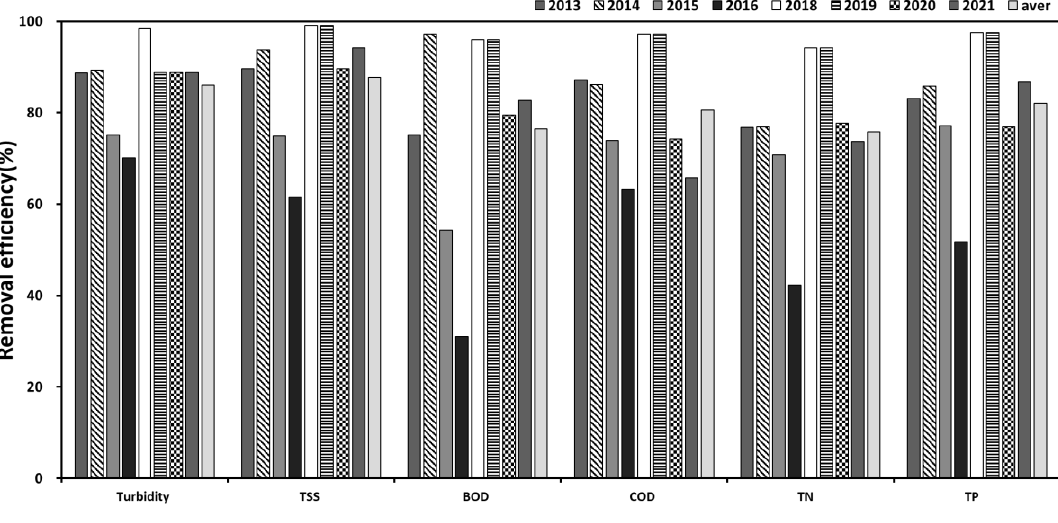
Figure 5. Analysis of the pollutant removal efficiency by rainfall depth (x).